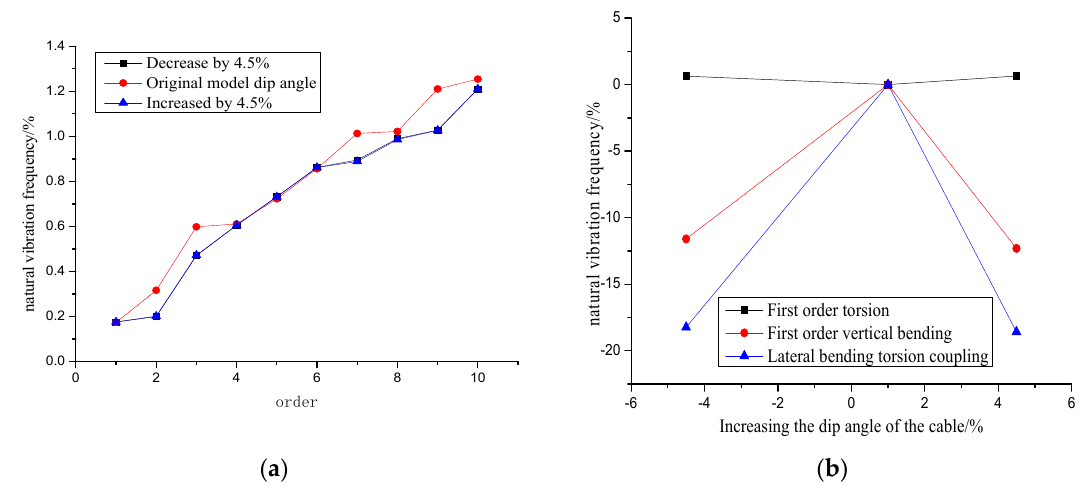
Figure 8. Influences of cable angles: ( a ) Influences of inclined angle of stayed cables on the first ten order natural frequencies; ( b ) the influence of dip angles on three key main modes.